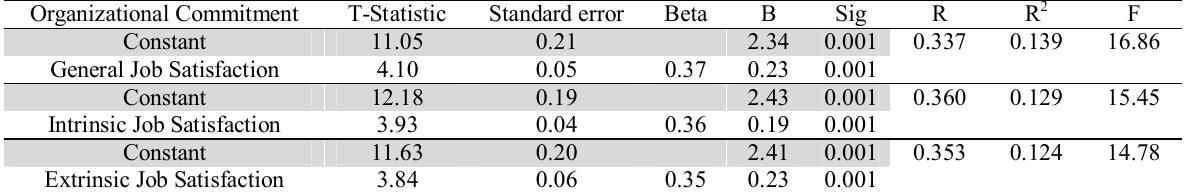
The regression analysis for predicting effect of intrinsic, extrinsic and general job satisfaction on organizational commitment Organizational